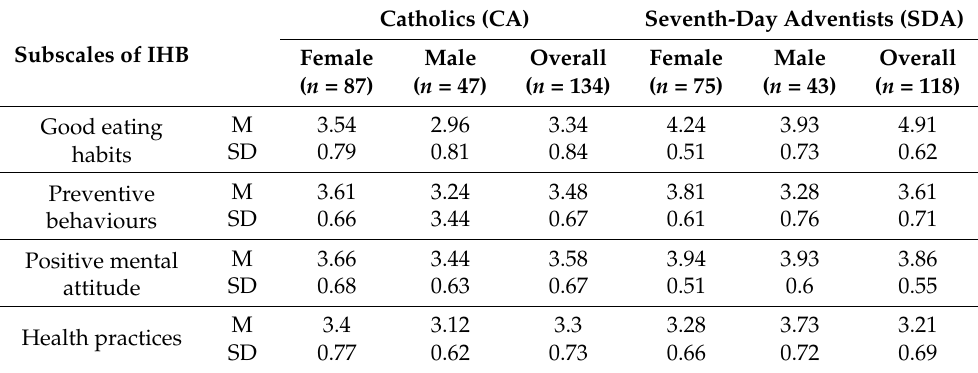
Table 7. Mean results for SDA and CA on particular subscales of the Inventory of Health Behaviours (IHB).